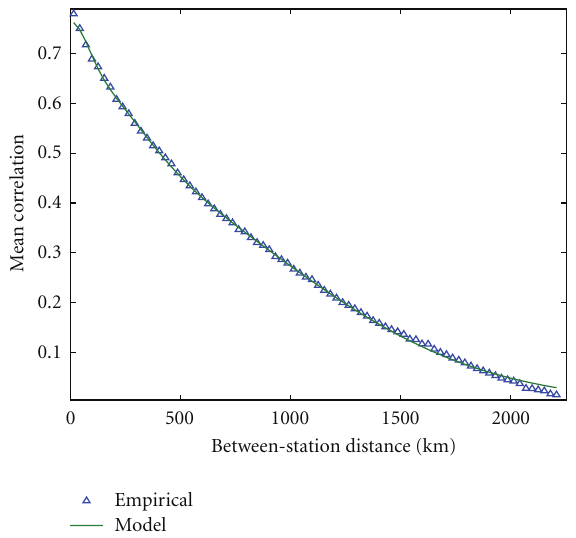
Figure 3: Correlation of annual minimum temperature time series between pairs of stations as a function of the distance between them.